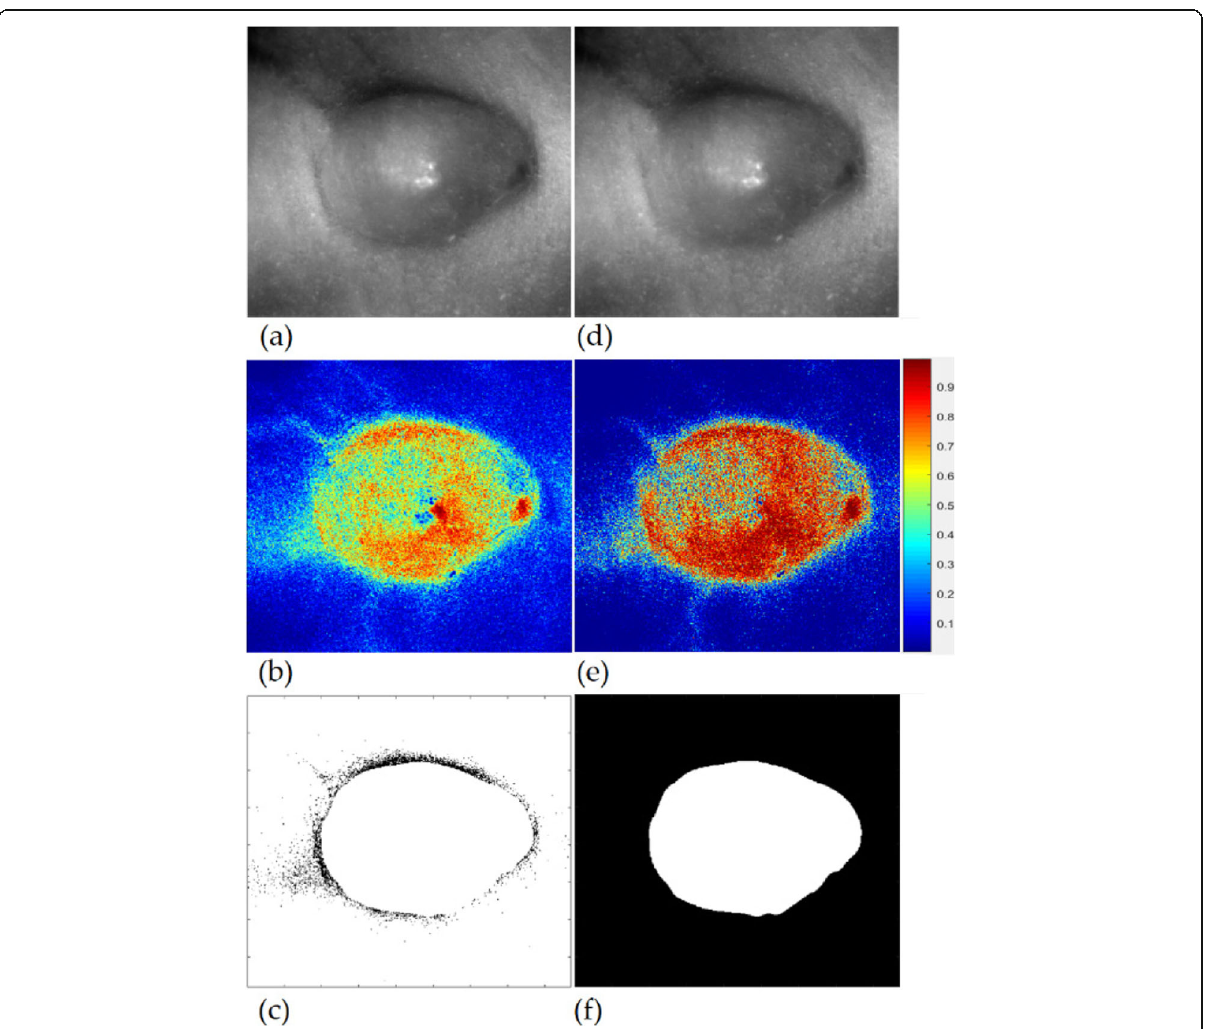
Fig. 8 The advantage of adaptive weight learning on the cancer detection. a : the original gray image, b : the probability image predicted for the original image, c : the adaptive weighted image, d : the updated image based on the adaptive weight, e : the updated probability image predicted for the updated image, f : the gold standard of the cancer